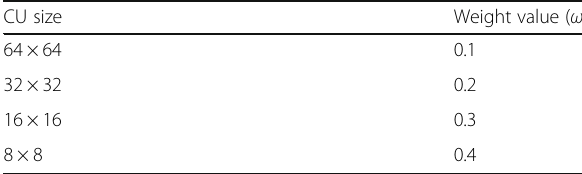
Table 7 Search range adjustment using MD